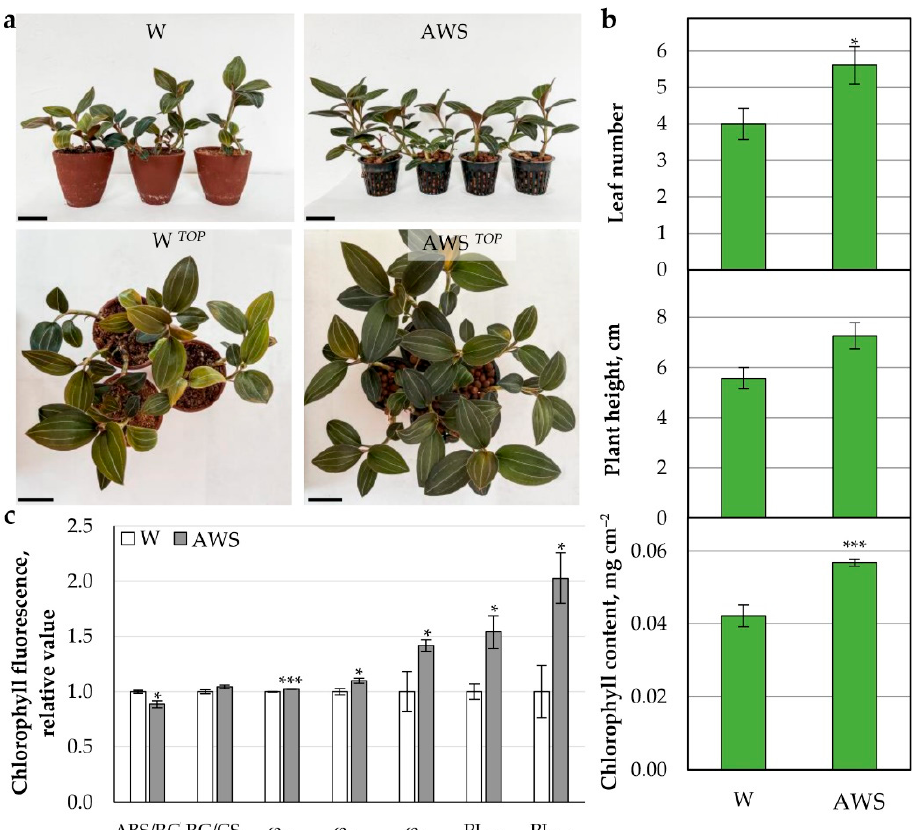
Figure 4. Growth of L. discolor in AW system (AWS). The plants were cultivated 2 months as hydroponic cultures and transferred in soil for 2 months and in AWS for 8 months. ( a ) Photo of the variants: W—water irrigation in soil; AWS—aquaponic water system; Scale bar: 5 cm. ( b ) Leaf number per plant, plant height, and chlorophyll content. ( c ) Chlorophyll fluorescence parameters. Statistically significant differences compared with the control W are shown with asterisks after applicationof Student’s t -test (* p ≤ 0.05; *** p ≤